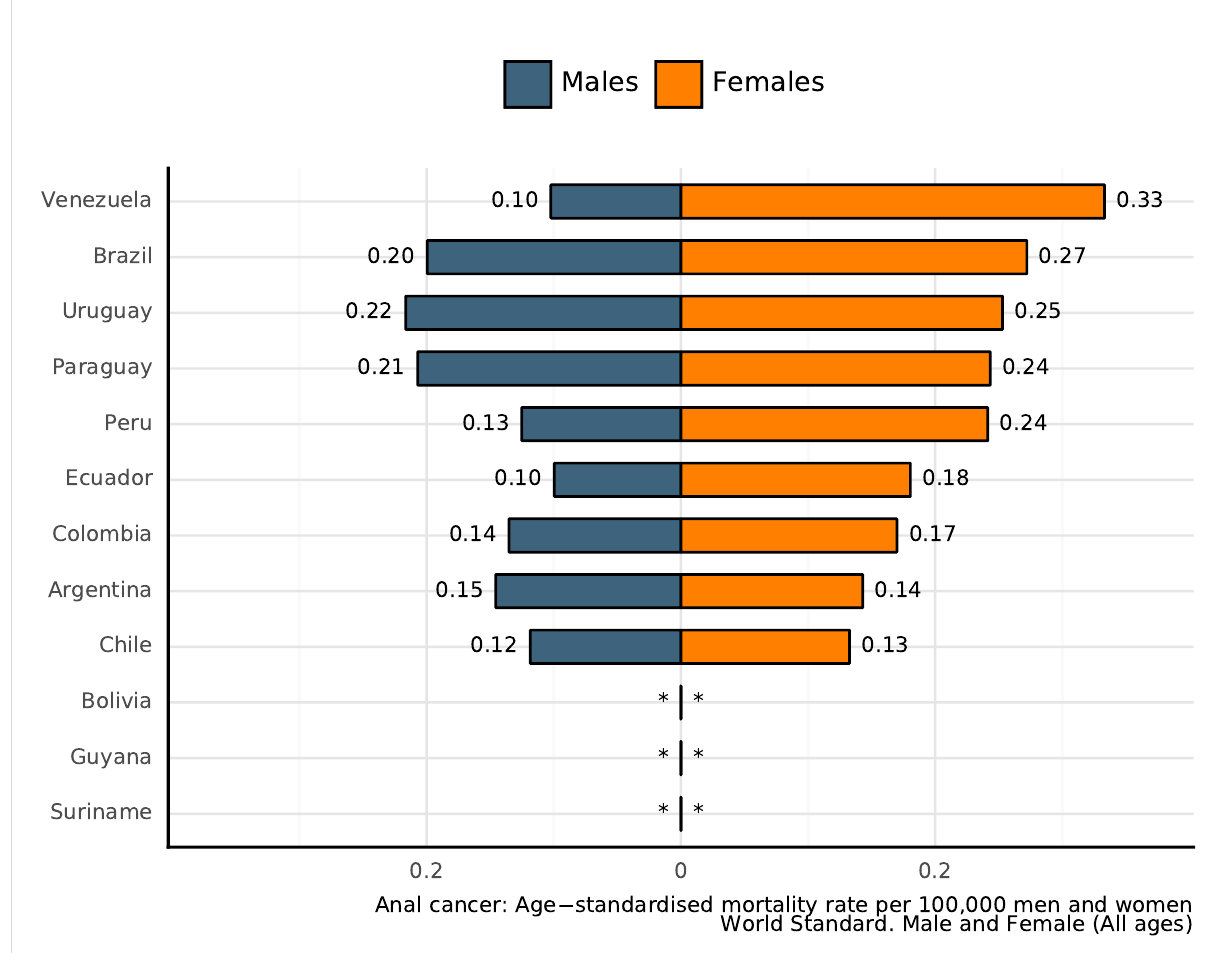
Anal cancer: Age standardised mortality rate per 100,000 men and women World Standard. Male and Female (All